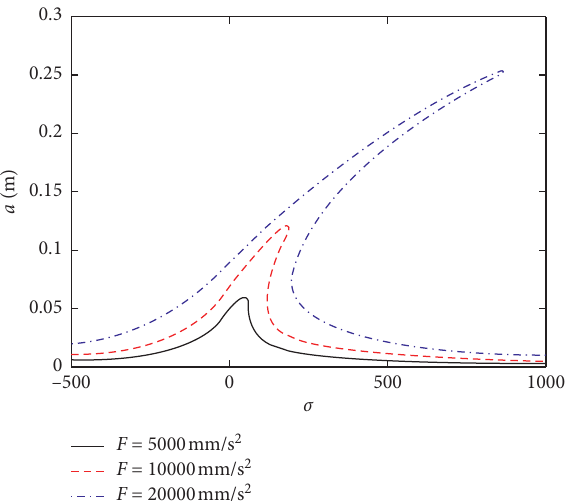
Figure 15: Effect of the amplitude of the periodic exciting force on primary resonance curves.